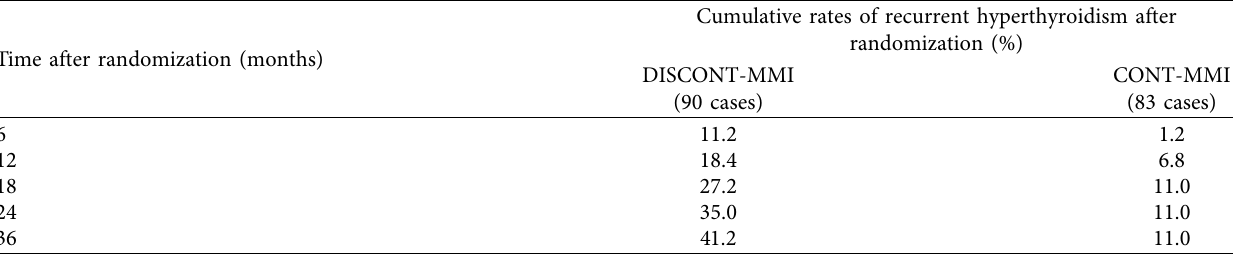
Table 2: Cumulative rates of recurrent hyperthyroidism in 173 patients randomly assigned to discontinue and continue low-dose methimazole therapy.